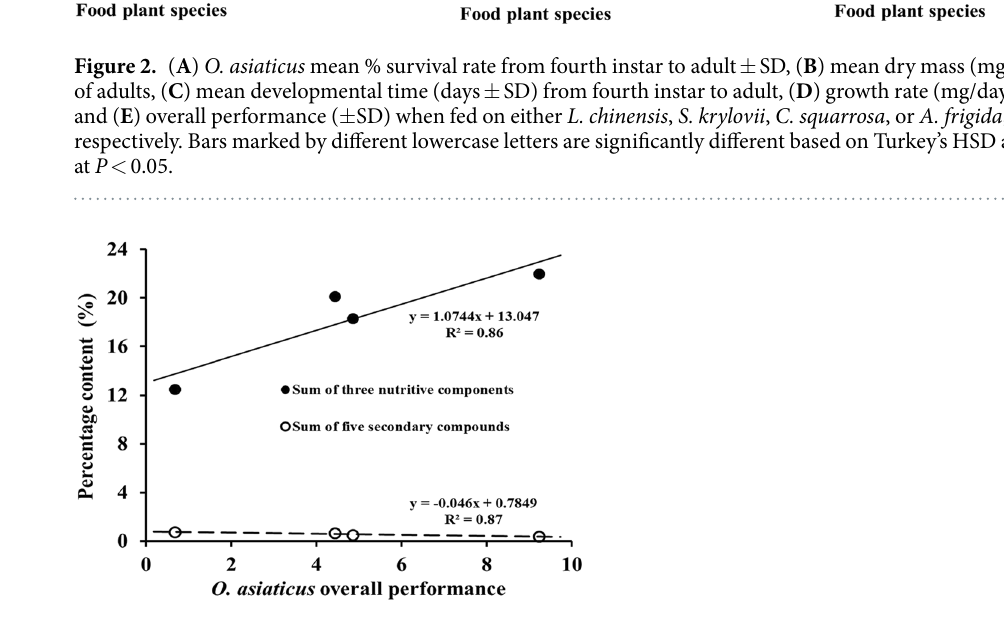
Figure 3. Linear relationship of O. asiaticus mean overall performance with the sum of three nutritive components (crude protein, lipid, starch) and five secondary compounds (alkaloids, flavonoids, phenols, tannins, terpenoids),